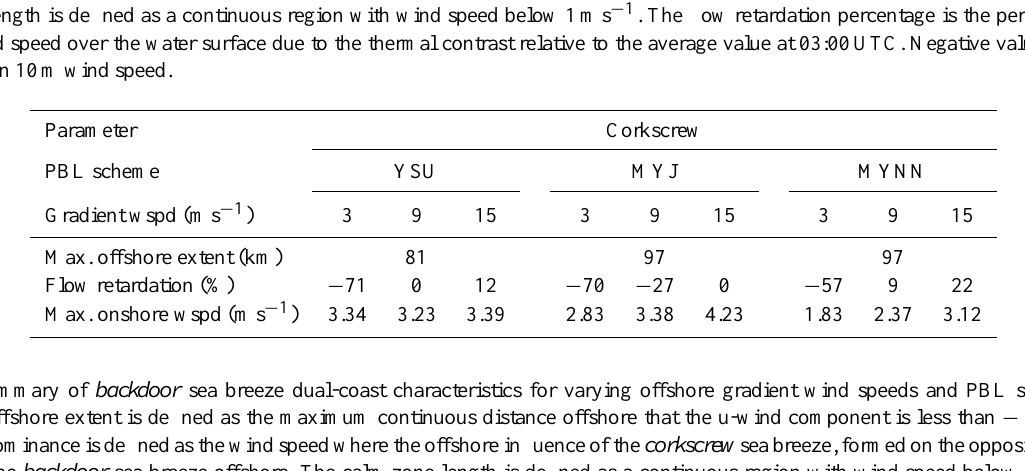
Table 6. Summary of backdoor sea breeze dual-coast characteristics for varying offshore gradient wind speeds and PBL schemes. The maximum offshore extent is defined as the maximum continuous distance offshore that the u-wind component is less than − 1ms − 1 . The corkscrew dominance is defined as the wind speed where the offshore influence of the corkscrew sea breeze, formed on the opposing coastline, suppresses the backdoor sea breeze offshore. The calm zone length is defined as a continuous region with wind speed below 1ms − 1 . The flow retardation percentage is the percentage drop in 10m wind speed over the water surface due to the thermal contrast relative to the average value at 03:00UTC.